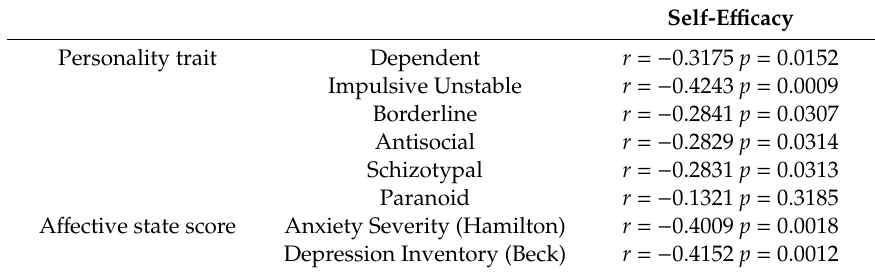
Table 2. Pearson correlations between perceived self-e ffi cacy, personality traits, and a ff ective state at baseline visit.